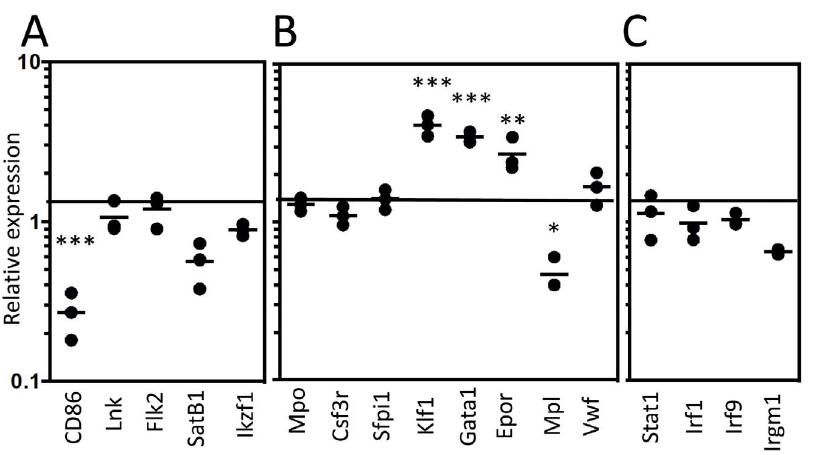
Figure 3. Erythropoiesis associated transcripts are overrepresented in JAK2V167F HSC. Gene expression analysis was performed by Real- Time PCR on a small panel of genes, normalizing with GAPDH for a reference housekeeping gene. Lymphoid genes ( A ) , myeloid-, erythroid-, and megakaryocytic- genes ( B ) , and IFN c responsive genes ( C ) were indicated. The data are representative of those obtained in two independent experiments p , 0.001(***), p ,